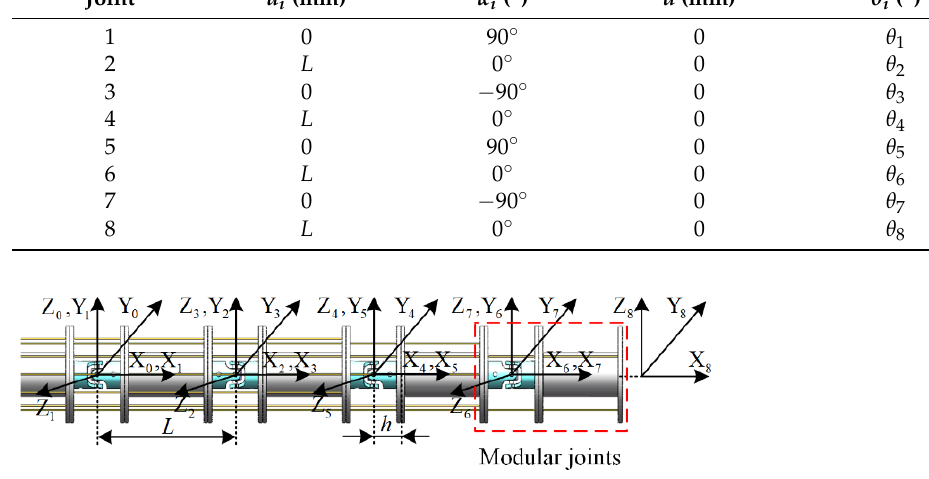
Table 1. D-H Parameters.